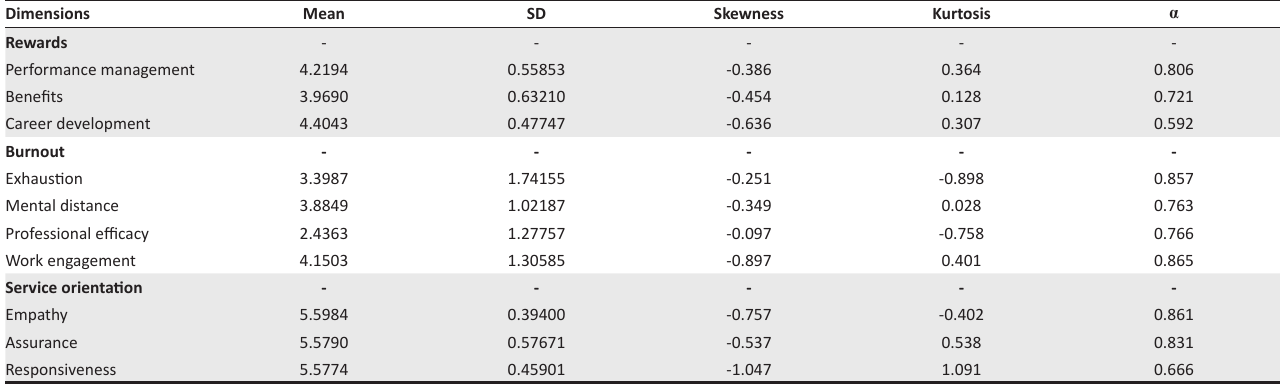
TABLE 1: Descriptive statistics of the measurements.